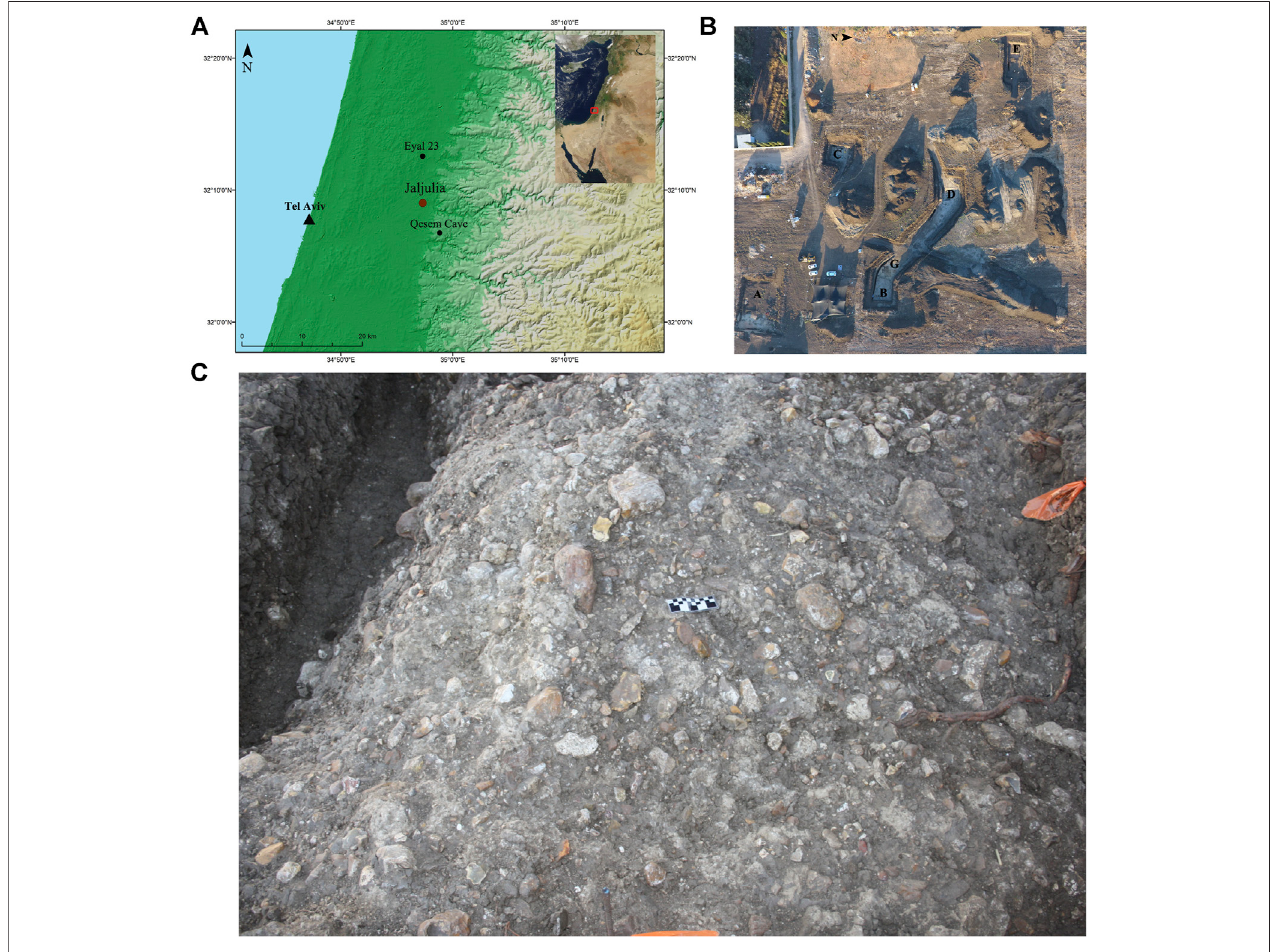
FIGURE 1 | (A) The location of Jaljulia, and major archaeological sites in its vicinity; (B) Aerial view of areas of excavation in Jaljulia, looking west. Note the ancient wadi in the south-eastern part of Area A (appears in light brown); (C) The conglomerate on top of which the site of Jaljulia was situated, as seen in Area